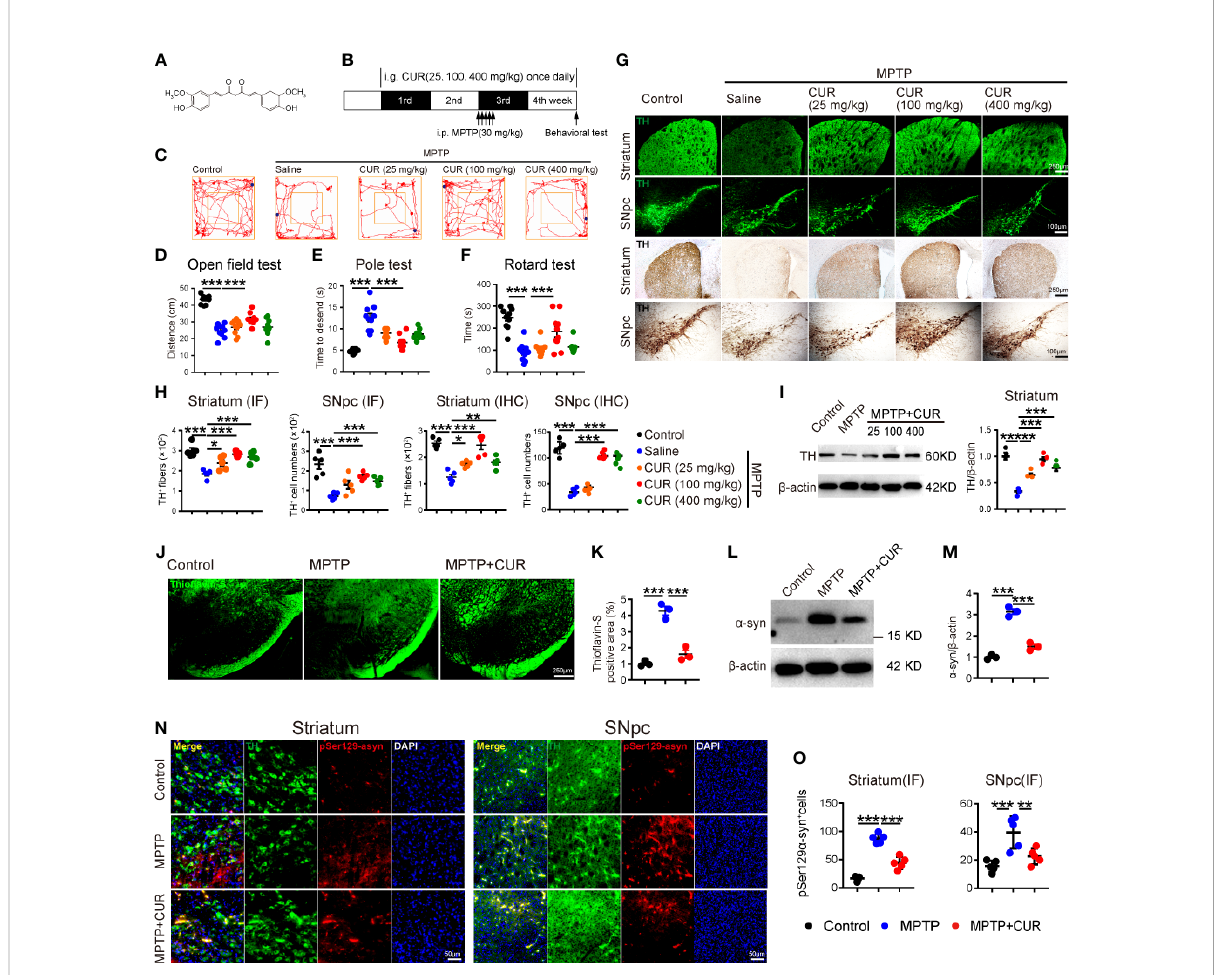
FIGURE 1 CUR administration prevented motor impairments, dopaminergic neuronal loss and a -synuclein aggregation in MPTP-induced PD mice. Male C57BL/6 mice were received intragastric administration of CUR (25,100,400 mg/kg) once a day for 4 weeks. On day 15, mice were treated with 200 m L saline containing MPTP (30 mg/kg) or 200 m L saline via intraperitoneal injection every day for a total of 5 times to establish PD mice model. On day 28, behavioral tests were performed to evaluate the motor function and the mice were sacri fi ced to determine the pathology of PD by immunohistochemistry, immuno fl uorescence and immunoblot. (A) The molecular structure of CUR. (B) The experimental design of CUR intervention in MPTP-induced PD mice. (C, D) Representative traces and quanti fi cation of the open fi eld test among MPTP treated mice, CUR treated mice and controls (n = 10). Bluepoint: starting position; Redpoint: ending position. (E, F) Quanti fi cation of performance in the pole test and the rotarod test among 5 groups (n = 10). (G) Representative immuno fl uorescence (upper) and immunohistochemistry (lower) images of TH-positive fi bers and